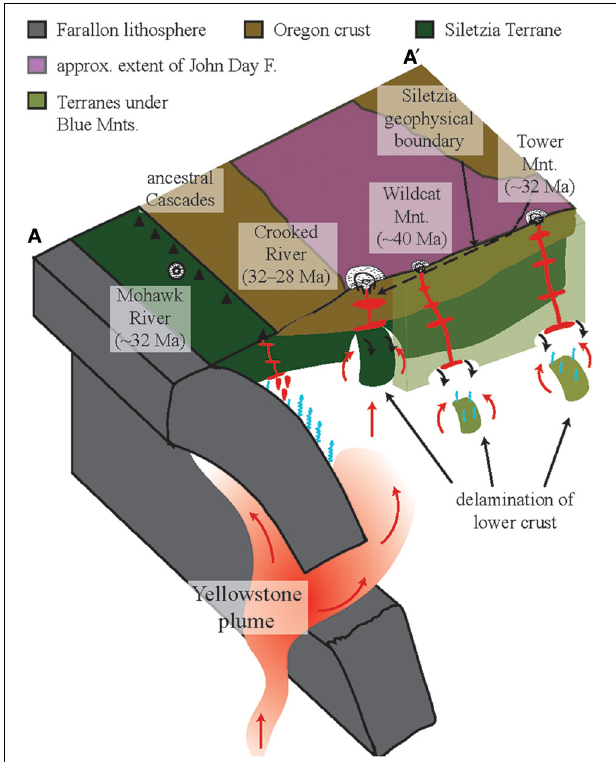
FIGURE 7 | Schematic diagram illustrating the magmatic/tectonic setting that prevailed during formation of the four newly identified calderas. Small-scale delamination, devolatilization, and hydrous mantle melting of delaminated terranes underlying the Blue Mountains along the suture with the Siletzia terrane results in the magmas erupted from the Tower Mountain and Wildcat Mountain calderas. The largest episode of delamination (of the Siletzia terrane) produced the magmas of the Crooked River (super) caldera, aided by encroachment of Yellowstone plume. The location and compositional characteristics of the Mohawk River caldera ( Figures 1 , 2 ) are consistent with subduction-related arc magmatism. The location of the A–A (cid:3) transect is shown in map view in Figure 1